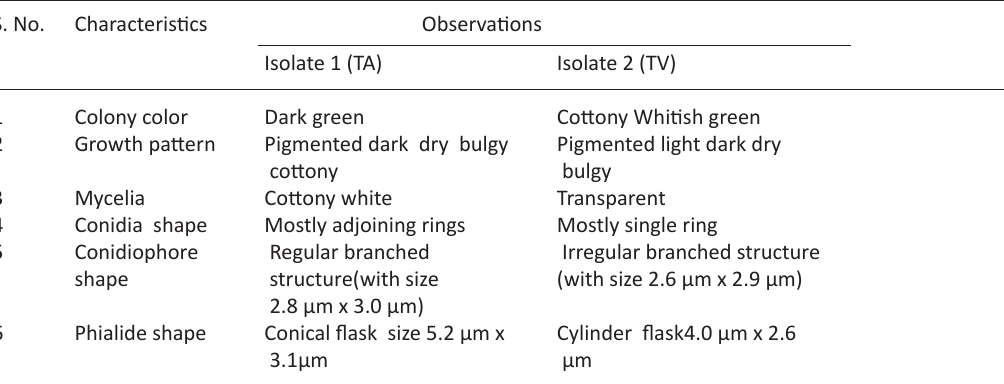
Table 2. A comparative observation (visual and microscopic) of isolates of TS (TA and TV) S.